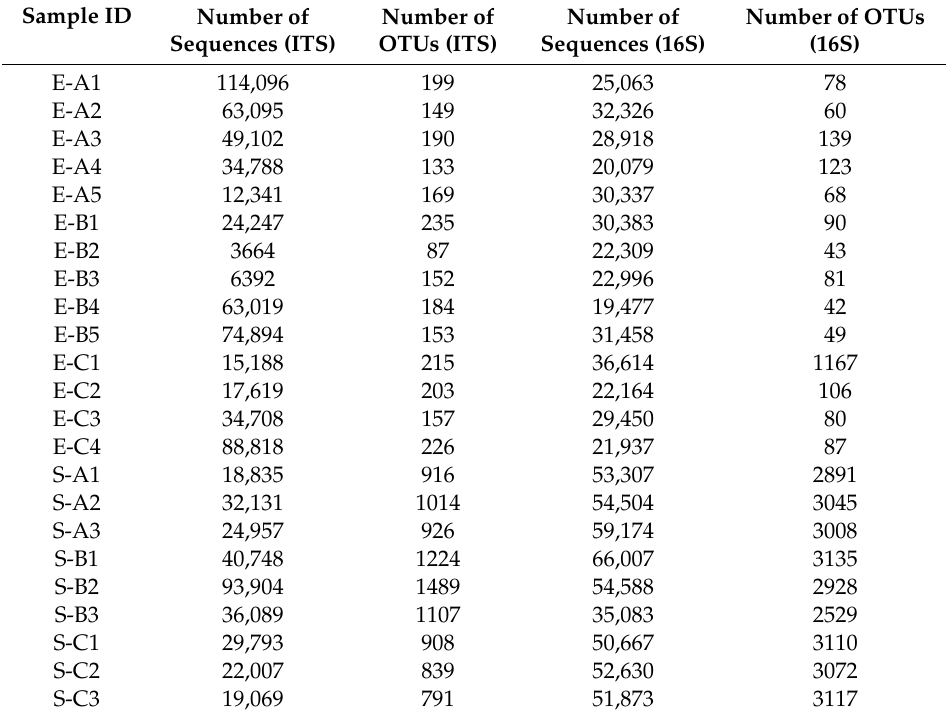
Table A1. The number of the obtained high-quality sequences and the corresponding OTU number from each